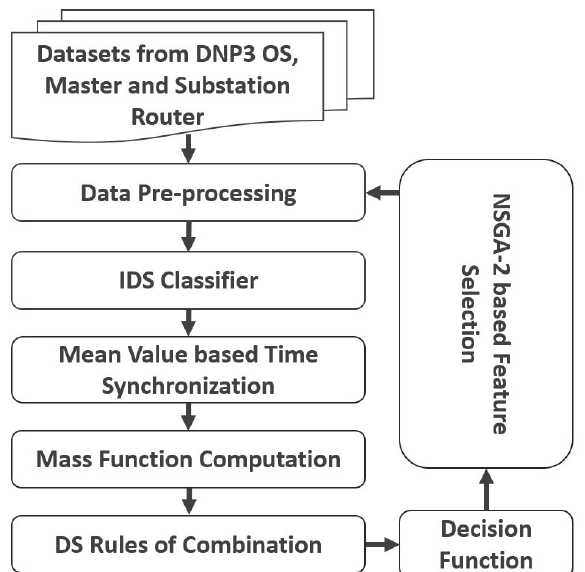
Figure 1. Sequence of